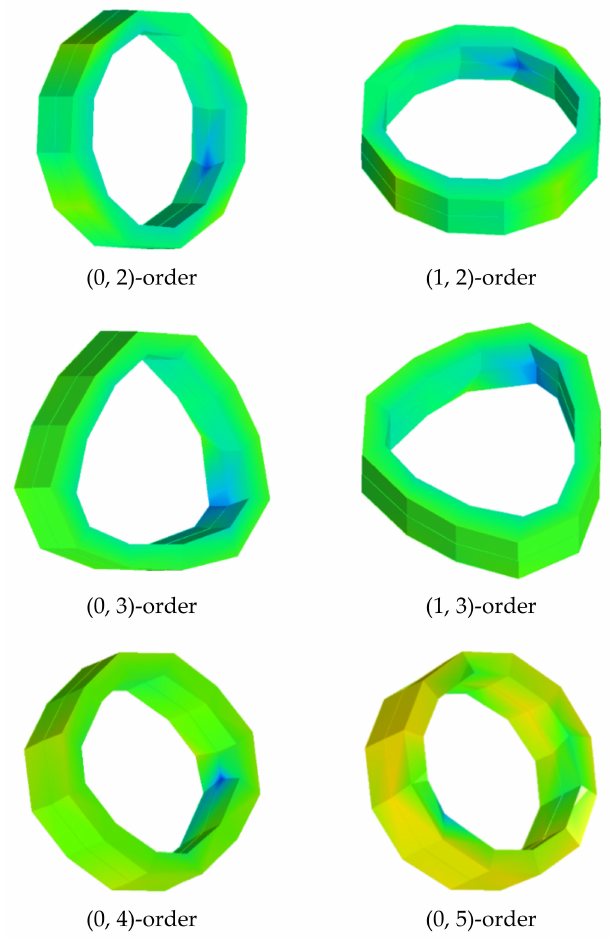
Figure 8. Modal shapes of motor stator without